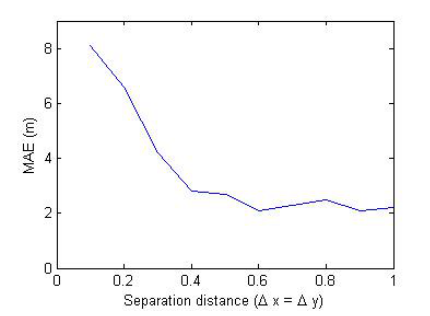
Figure 12. Influence of sensor separation distance on the mean absolute error (MAE).